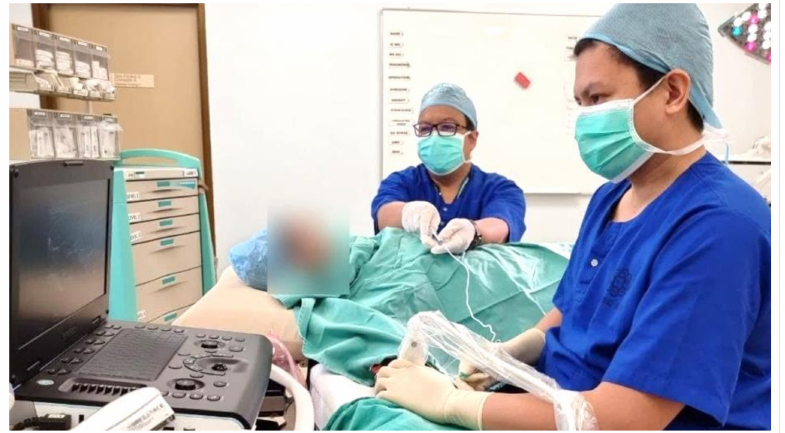
Figure 1. Monitor located in front of the operator, at the level of the hands, allowing gaze-down viewing and alignment of the visual and motor axes in front of the